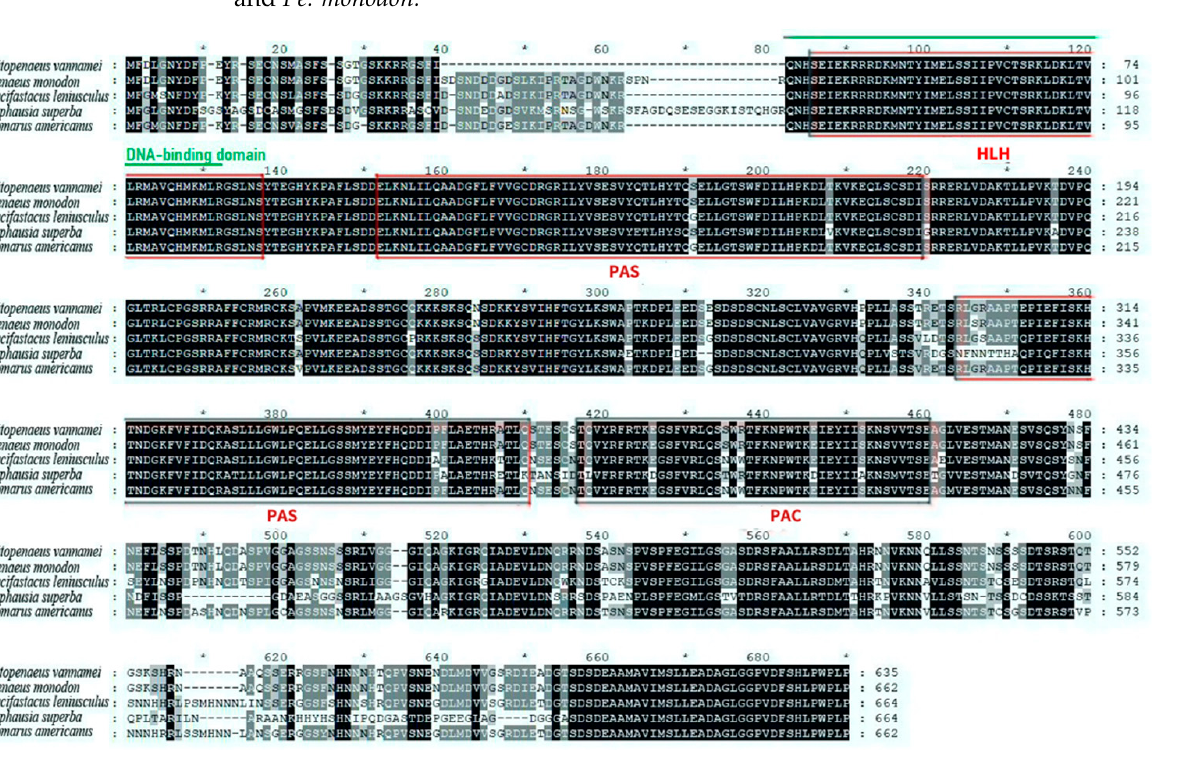
Figure 2. Alignment of the sequences of BMAL1. The consensus residues are in black, the conserved domains and motifs are indicated in red, and DNA-binding domains are in- dicted in green. The genBank accession numbers of the aligned sequences are as follows: L. vannamei , ROT67541.1; Pa. leniusculus , AFV39705.1; E. superba , ANW48377.1; H. ameri- canus , AWC08576.1; Pe. monodon , XP_037792710.1. 3.3. Overexpression of BMAL1 Significantly Activated the Gene Expression of GLUT1 and SGLT1 in Vitro